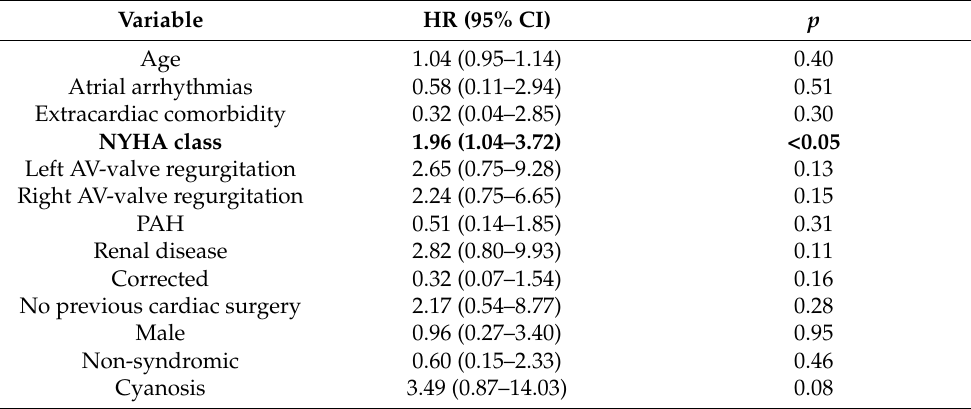
Table 3. Univariate predictors for the primary